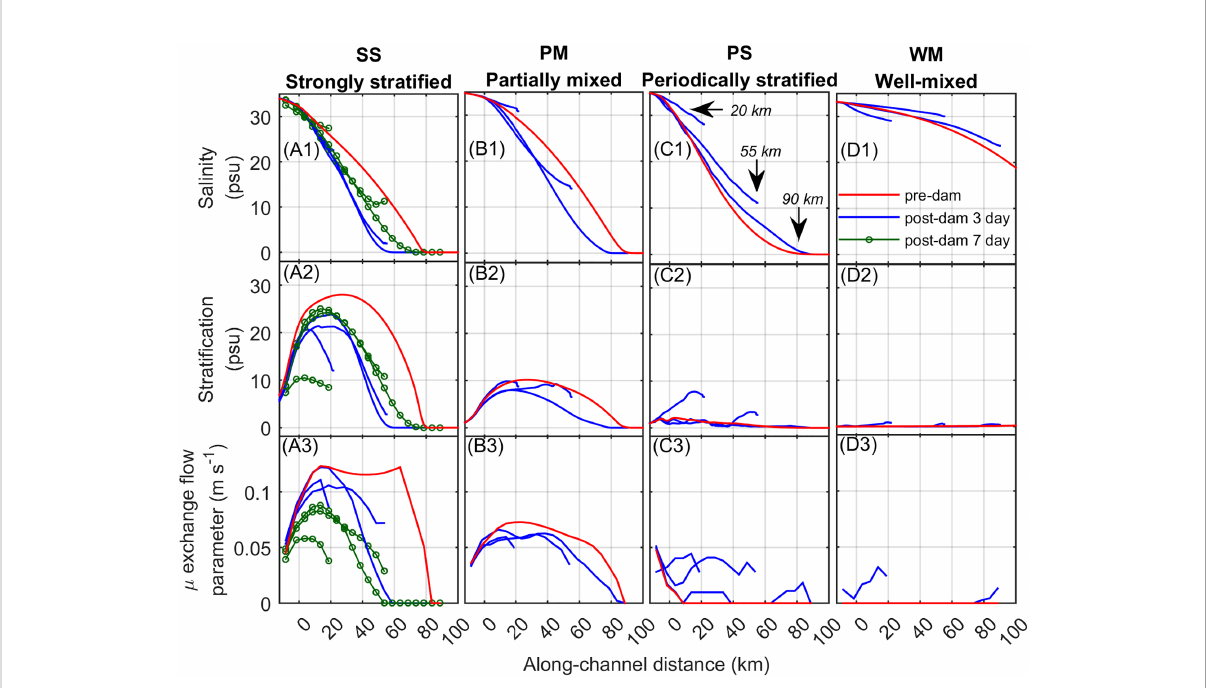
FIGURE 8 Along-channel pro fi les depending on estuarine type, dam location, and discharge interval of (A1-D1) depth-averaged salinity (psu), (A2-D2) top- to-bottom salinity strati fi cation (psu), and (A3-D3) estuarine circulation parameter m (m s -1 ). Along-channel distance is distance from the estuarine mouth (positive landward). Most post-dam data is for discharge interval D t = 3 days. The post-dam data for discharge interval D t = 7 days is shown for the strongly strati fi ed